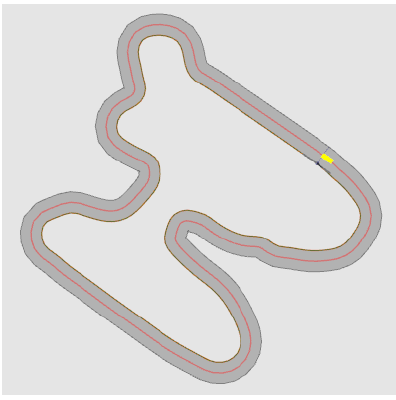
Figure 19. Long round driving test circuit , the red line represents the route, and the yellow square represents where the car starts